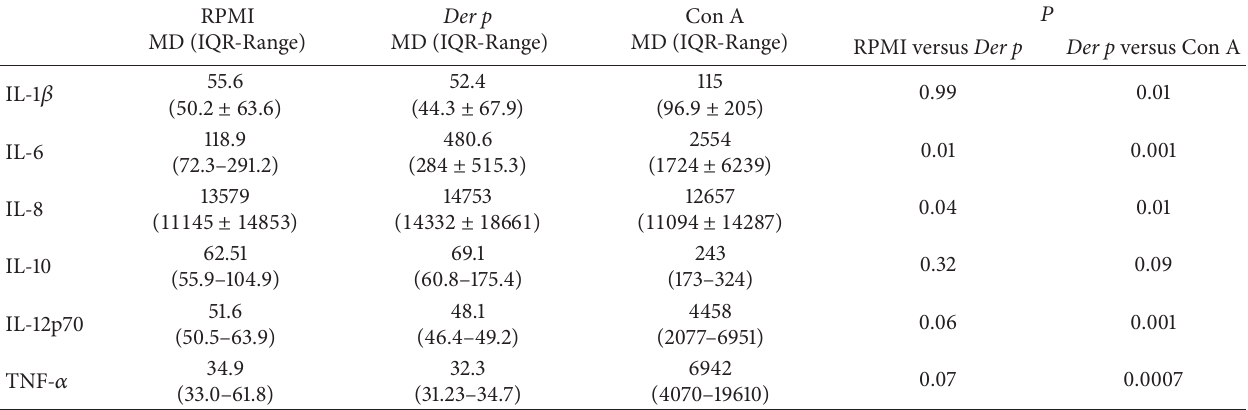
Table 3: Cytokines concentration in supernatants of cell